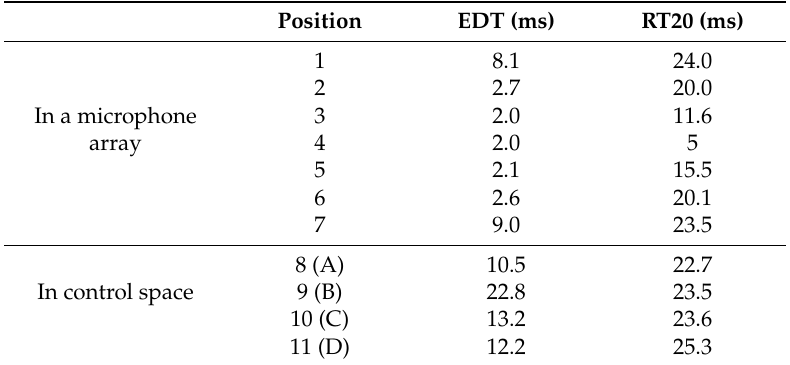
Table 3. Results of room acoustic parameters measured in the control space as in Figure 13 at positions shown in Figure